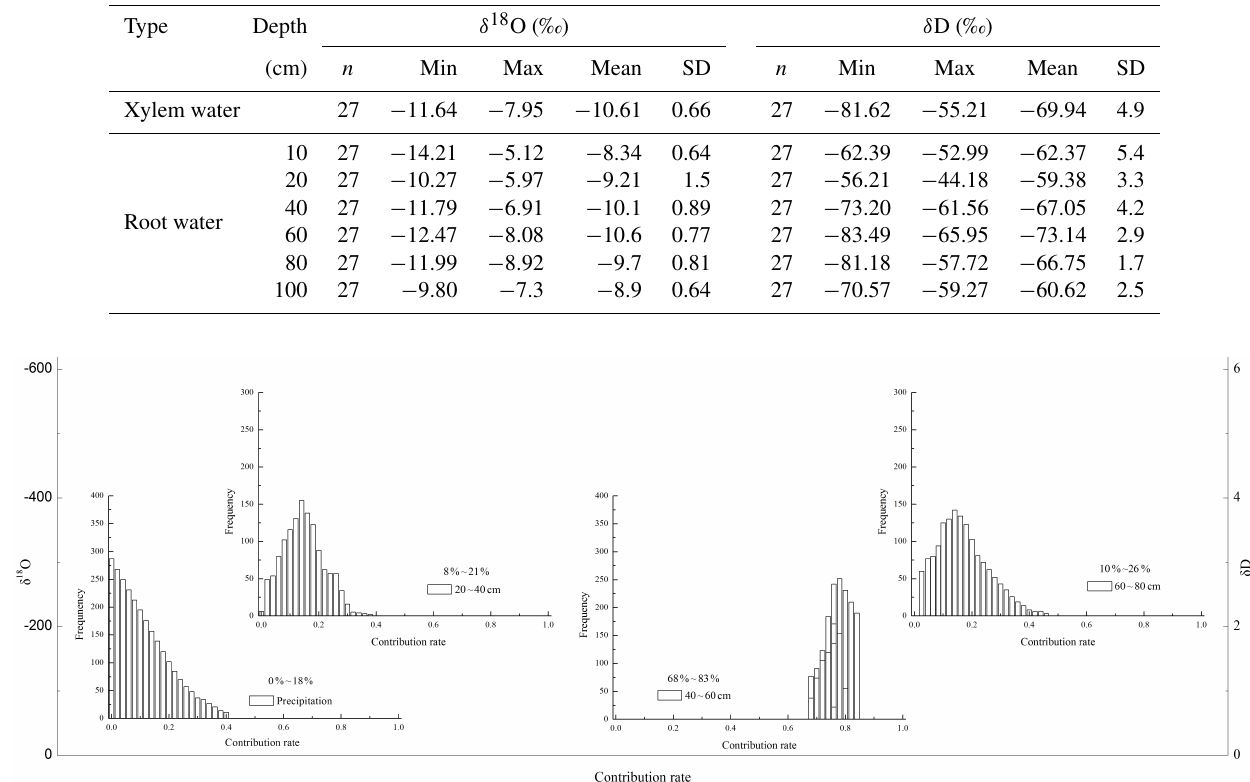
Figure 6. The contributions of each potential water source to plants.